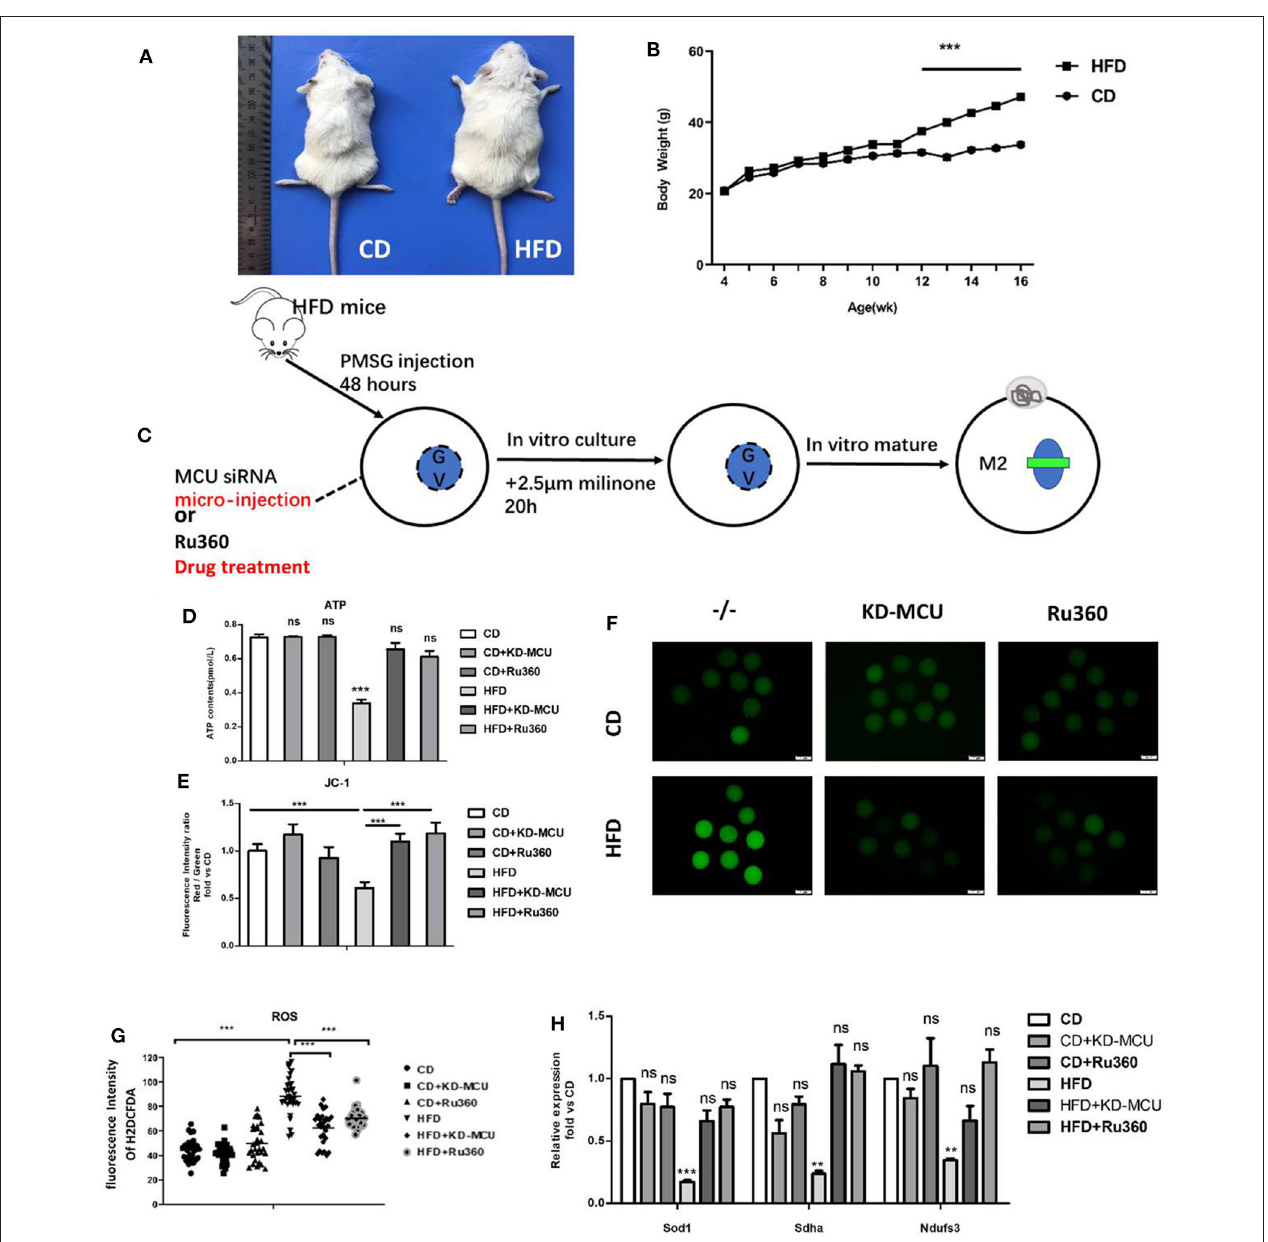
FIGURE 7 | Declining mitochondrial Ca 2 + rescues mitochondrial dysfunction in obese oocytes. (A,B) Female mice receiving a control diet (CD) or high-fat diet (HFD) for 13 weeks were evaluated for body weight ( n = 22 for each group). (C) The process about declining mitochondrial Ca 2 + in obese mouse oocytes by microinjection special siRNA sequence to knockdown expression about MCU or special inhibitor of MCU. (D) ATP (pM) concentrations were evaluated in individual oocytes from CD, CD + KD-MCU, and CD + Ru360 mice and HFD, HFD + KD-MCU, and HFD + Ru360 mice ( n = 30 for each group). (E) Oocytes from CD, CD + KD-MCU, and CD + Ru360 mice and HFD, HFD + KD-MCU, and HFD + Ru360 were stained with JC-1 and quantification of the relative levels of mitochondrial membrane potential ( 1 φ m) in oocytes ( n = 30 for each group). (F) Representative images of CM-H2DCFDA fluorescence (green) in germinal vesicle (GV) stage oocytes from CD, CD + KD-MCU, CD + Ru360 mice and HFD, HFD + KD-MCU, and HFD + Ru360 mice. Scale bar: 50 µ m. (G) Quantification of the relative levels of ROS in oocytes from CD, CD + KD-MCU, and CD + Ru360 mice and HFD, HFD + KD-MCU, and HFD + Ru360 ( n = 35 for each group). (H) Expression levels of genes involved in mitochondrial function ( Ndufs3 , Sdha , and Sod1 ) in HFD oocytes were rescued by declining mitochondrial Ca 2 + level ( n = 30 for each group). Student’s t- test and one-way ANOVA were utilized for statistical analyses. ** P < 0.01; *** P < 0.001; ns. means non-significant ( P > 0.05). Error bars indicate SEM.